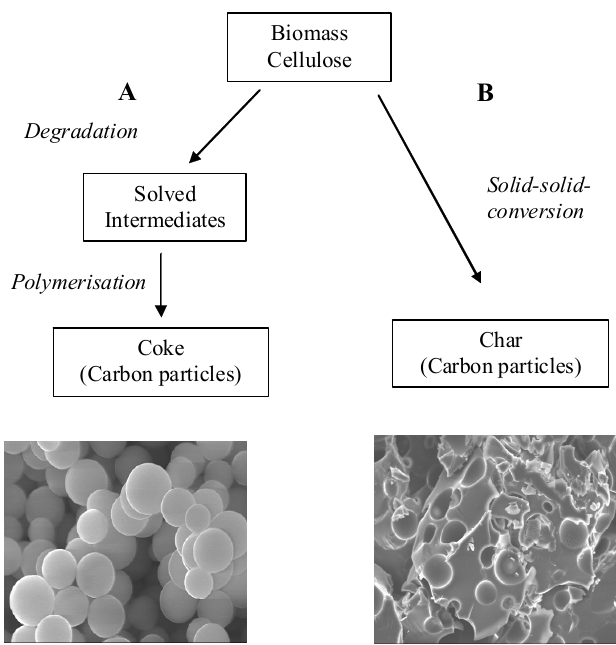
Figure 1. Primary reaction pathways A and B for the formation of HTC-coal (modified from [6]). A is a path via polymerization of solved molecules, B is a solid-to-solid conversion. The SEM pictures show hydrochar from glucose ( left ) and lignin ( right ).